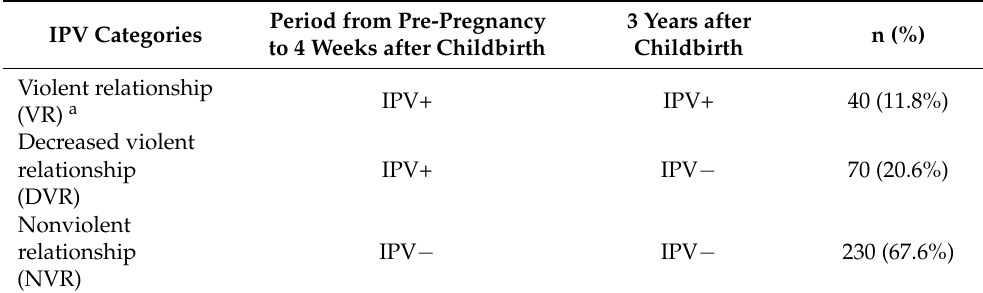
Table 1. Different Types of IPV Relationship According to IPV Exposure from Pre-Pregnancy to Three Years After Childbirth (n = 340).